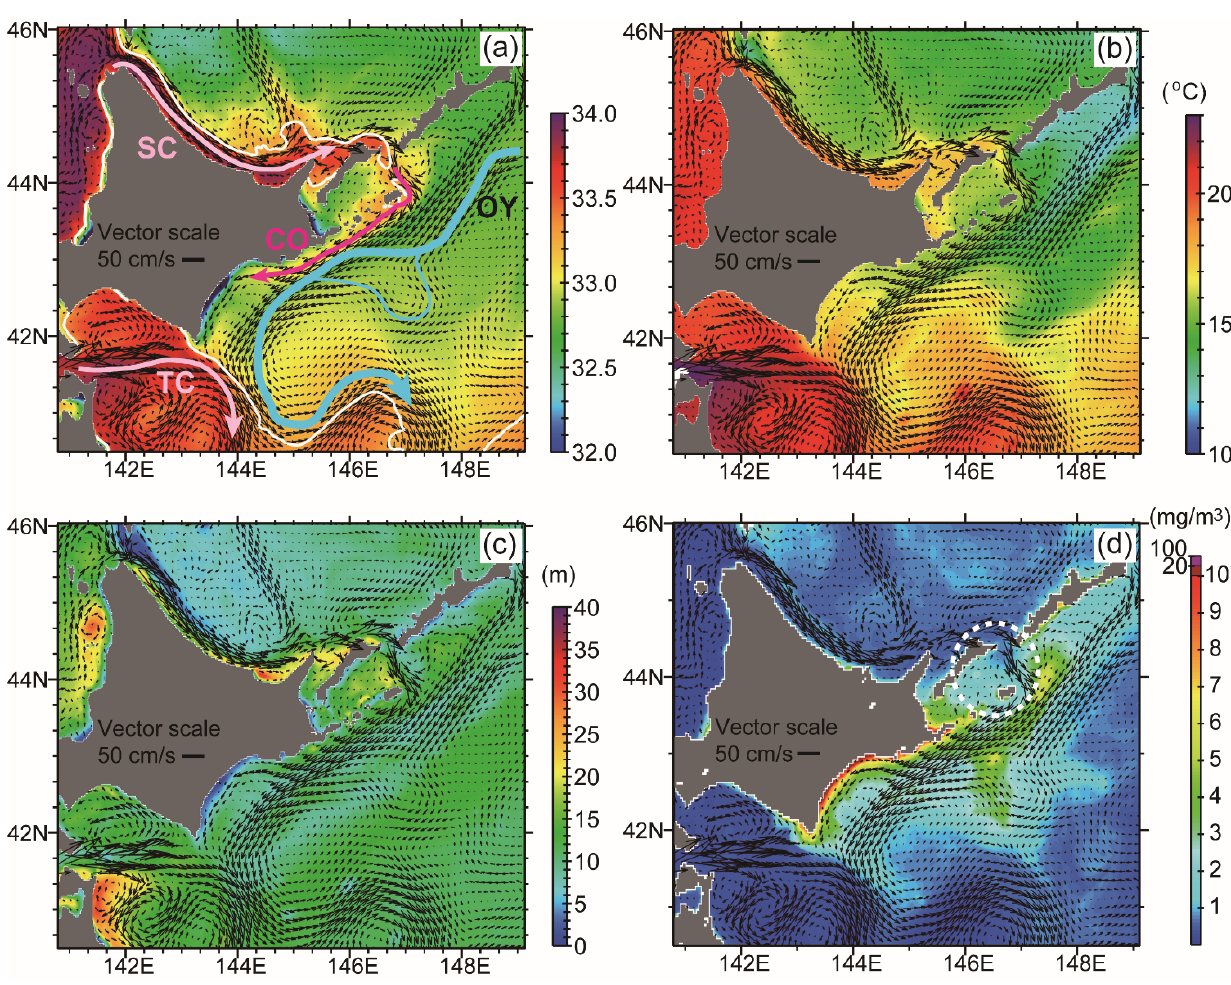
Figure 6. Monthly mean values in September 2021 of ( a ) simulated sea surface salinity, ( b ) sea surface temperature, ( c ) surface mixed layer depth, and ( d ) SCCs. Monthly mean velocities at the sea surface are overlaid on each panel. The 33.3 isohaline is denoted by the white line in ( a ). In addition, schematic views for some representative ocean currents are depicted in ( a ); SC (Soya Warm Current), CO (Coastal Oyashio), OY (Oyashio), and TC (Tsugaru Warm Current). SCCs are based on near-real-time L4